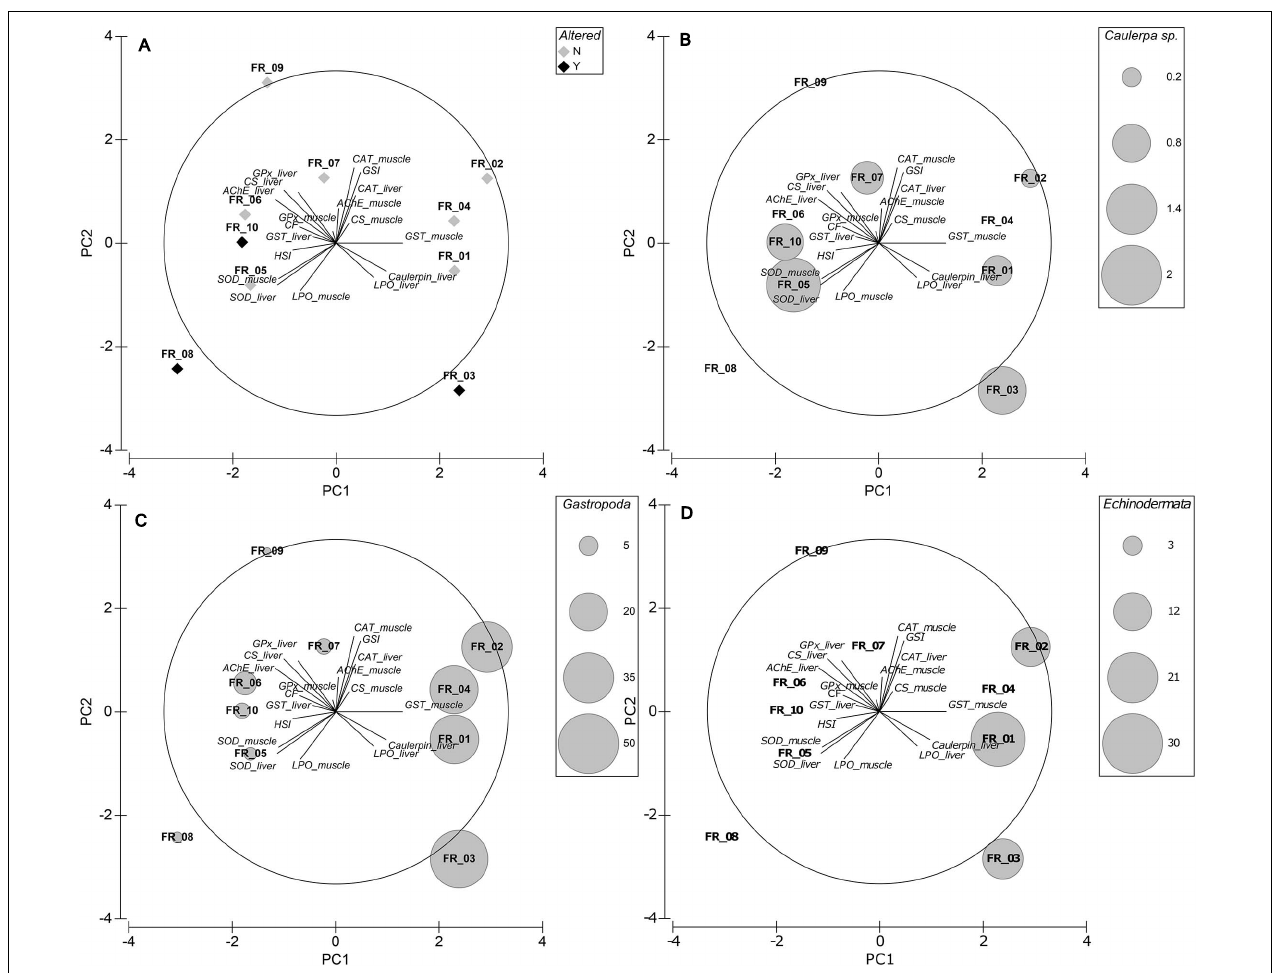
FIGURE 6 | Exploratory MVA analysis. Principal components analyses of biomarker data superimposed on the eigenvector plot (A) , Caulerpa sp. relative stomach content fraction (B) , Gastropoda relative stomach content fraction (C) , and Echinodermata relative stomach content fraction (D) . PC1 and PC2 explain 27.8 and 17.4% of variation,